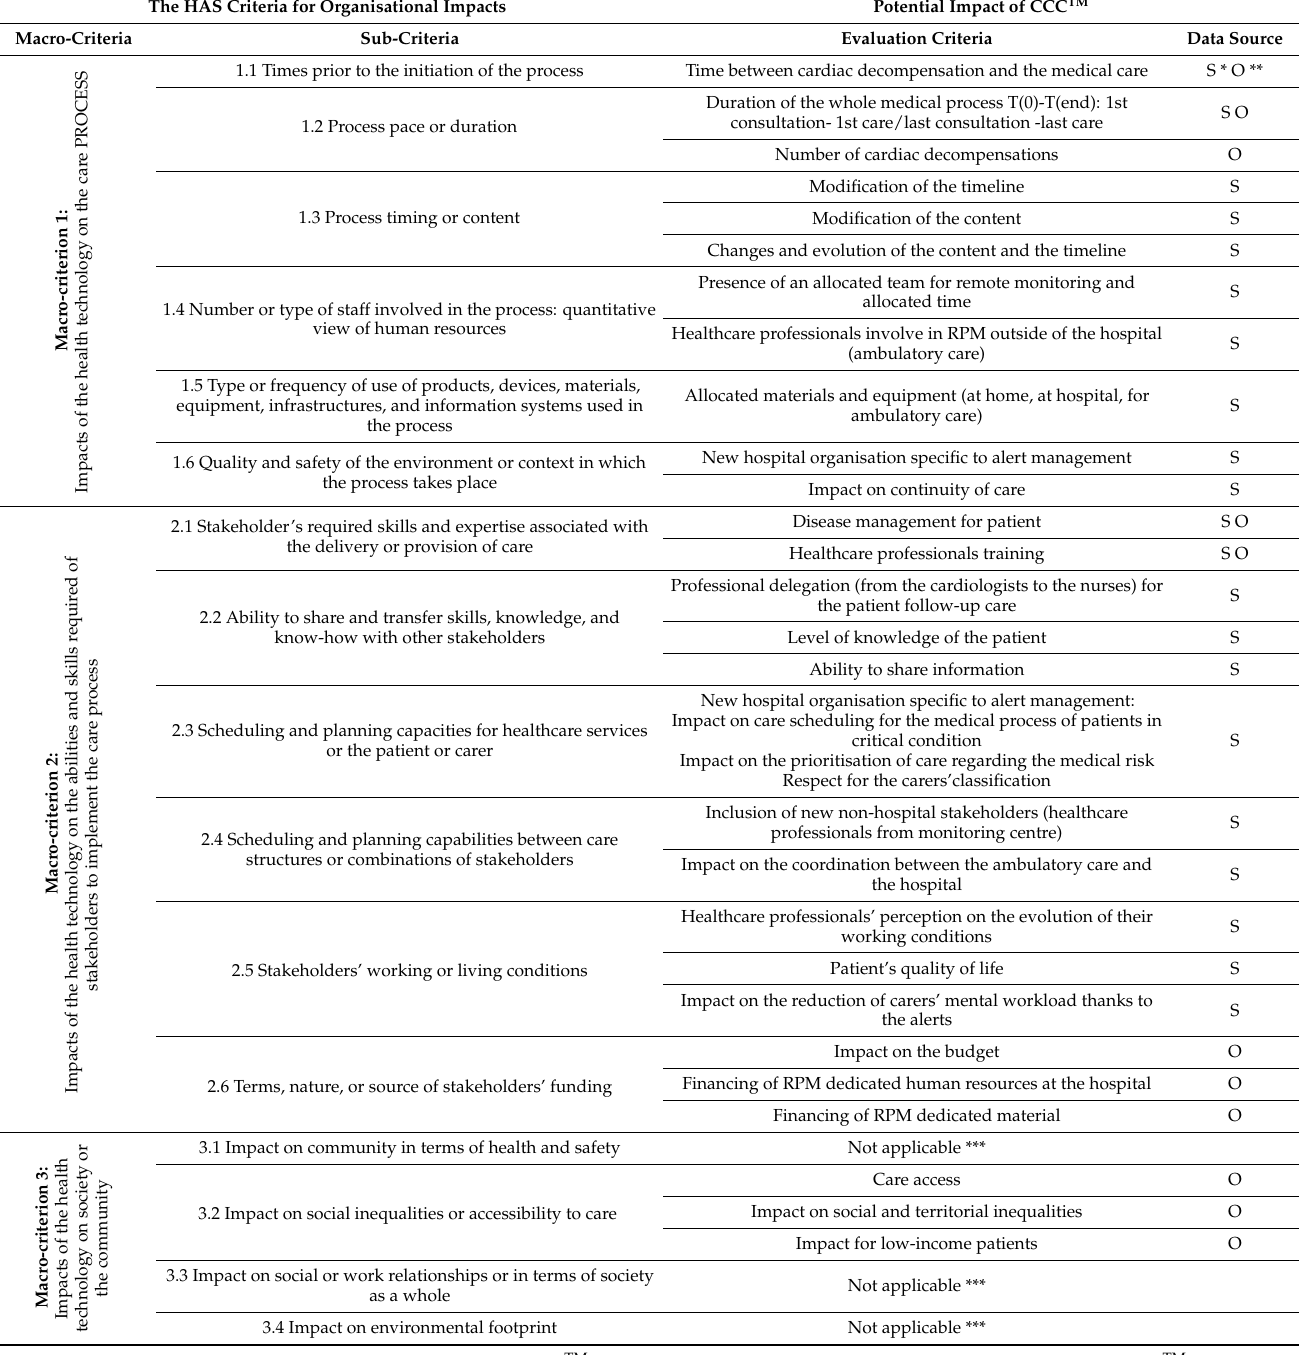
Table 1. The criteria for organisational impacts in the health technology assessment defined by the